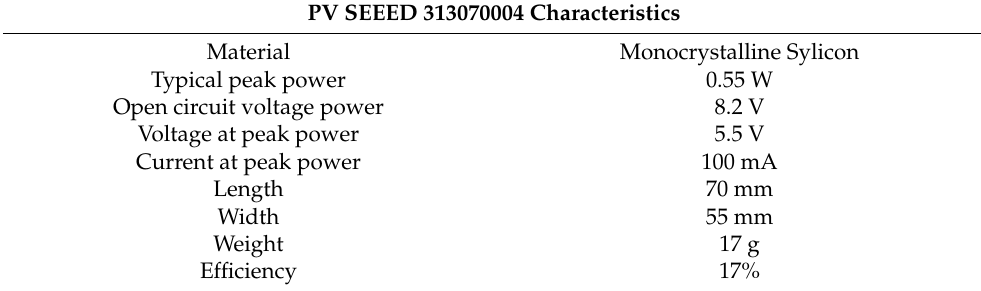
Table 2. Photovoltaic panel characteristics.